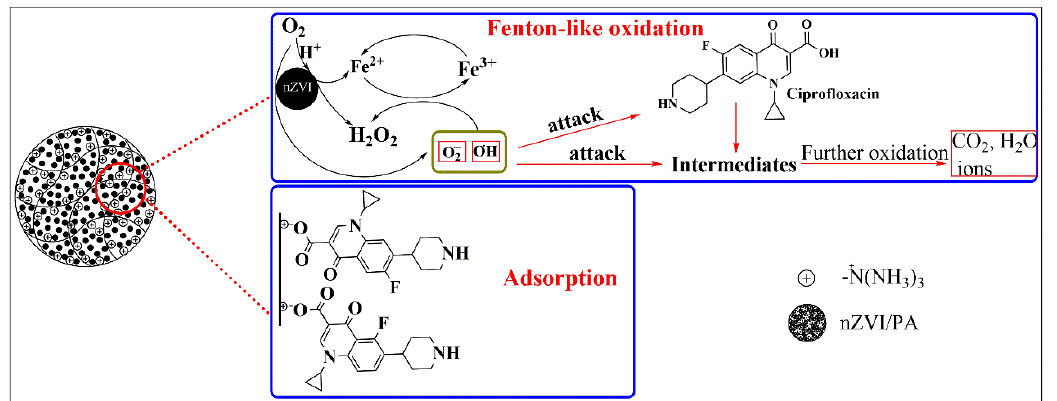
( d ) in nZVI/PA. O −  2